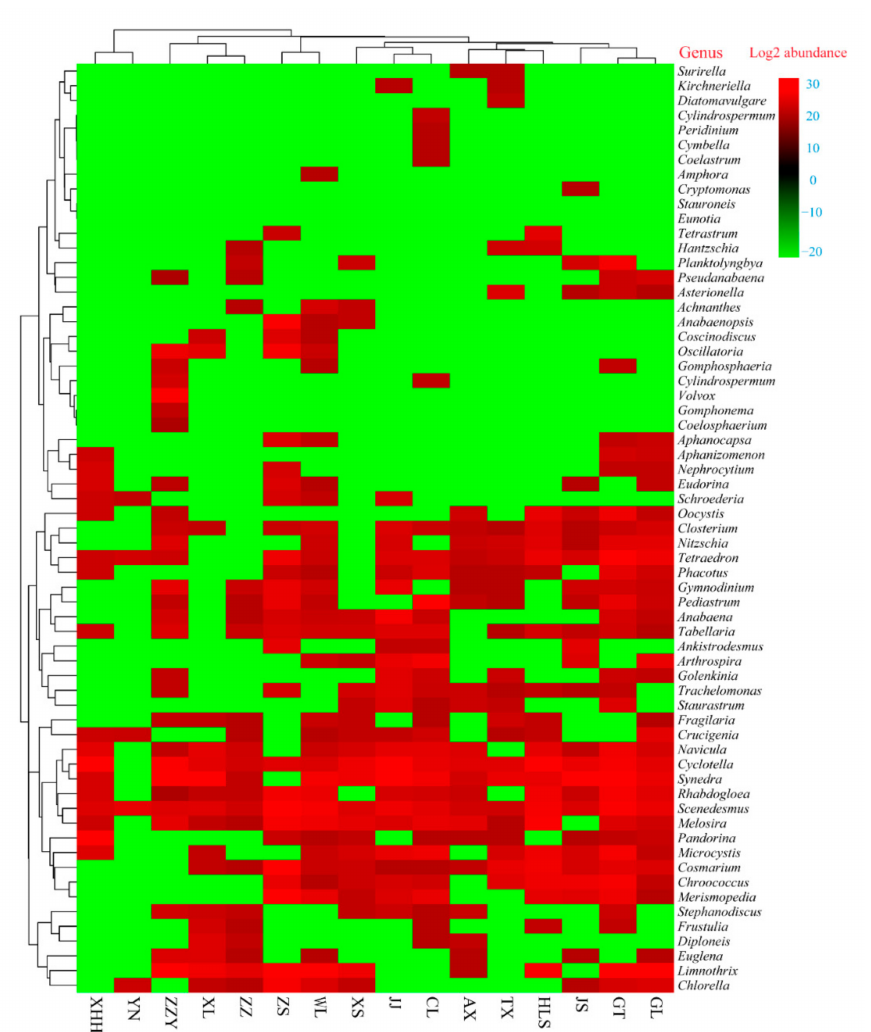
Figure 4. Heat map profile showing the algal community at the genus level in 16 di ff erent urban lakes. Green colors indicate lower abundance, red colors indicate higher abundance. GL, GT, JS, HLS, TX, AX, CL, JJ, XS, WL, ZS, ZZ, XL, ZZY, YN, and XHH represent GuiLong, GaoTie, JinSha, HuiLongShan, TieXi, AiXi, ChangLe, JinJi, XiangShan, WestLake, ZhongShan, ZhuZhai, XiLiu, ZiZhuYuan, YuNv, and XinHaiHu urban lakes,